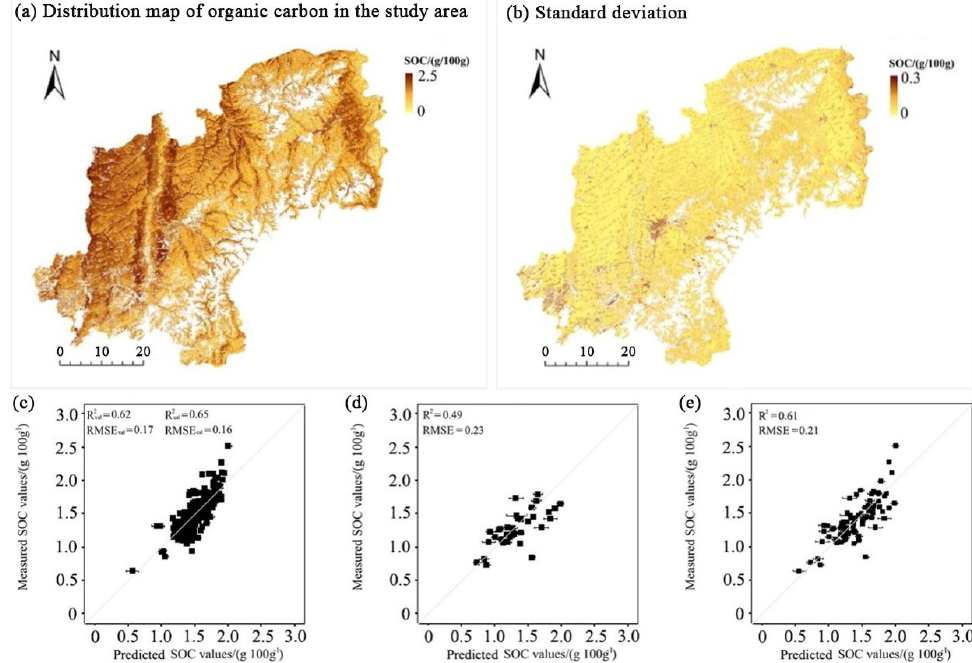
Figure 3. PLSR model validation results and spatial distribution of SOC based on multi-temporal S2 remote sensing spectral data set. ( a ) Spatial distribution map of SOC; ( b ) Spatial distribution of standard deviation of SOC; PLSR model validation results based on ( c ) modeling training data sets; ( d ) independent validation data sets; ( e ) the complete data